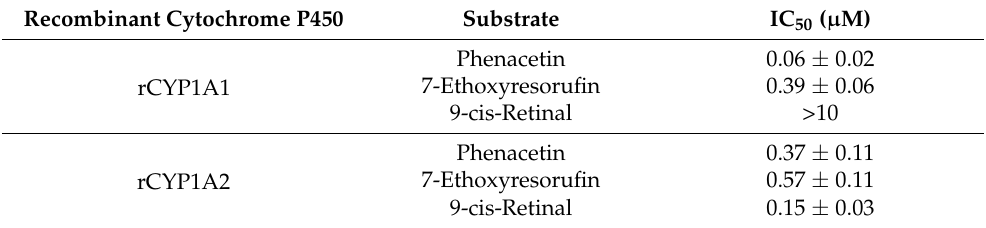
Figure 7. Inhibitory effects of obtusifolin on CYP1A1- and CYP1A2-mediated ethoxyresorufin O - deethylation in recombinant human CYP1A1 ( A ) and CYP1A2 ( B ) enzymes. Recombinant human P450s (10 pmol/mL) were incubated with ethoxyresorufin (2 µ M) in the presence or absence of obtusifolin (0–10 µ M) at 37 ◦ C for 20 min. The activity is expressed as the percentage of the control activity. The data are depicted as the average obtained from triplicate experiments ( n = 3). Table 5. Inhibitory effects (IC 50 ) of obtusifolin against recombinant CYP1A1 and CYP1A2.